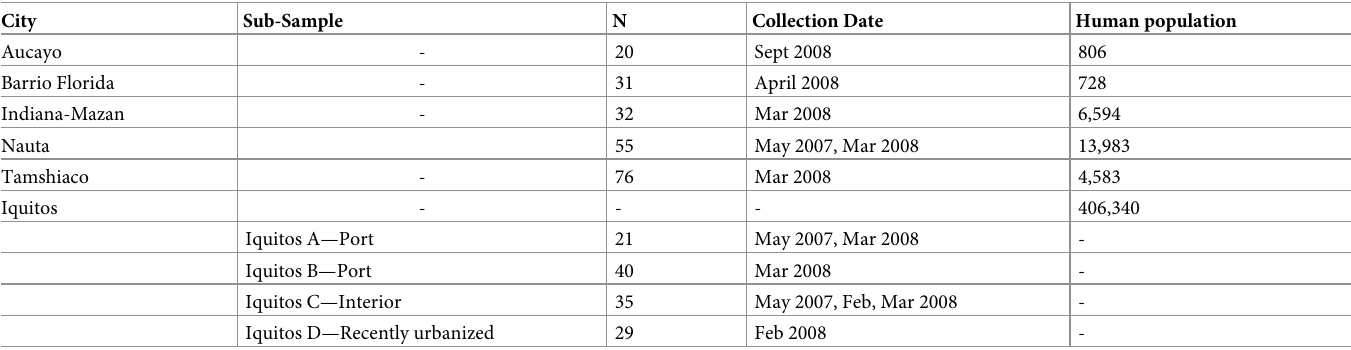
Table 1. Characteristics of study